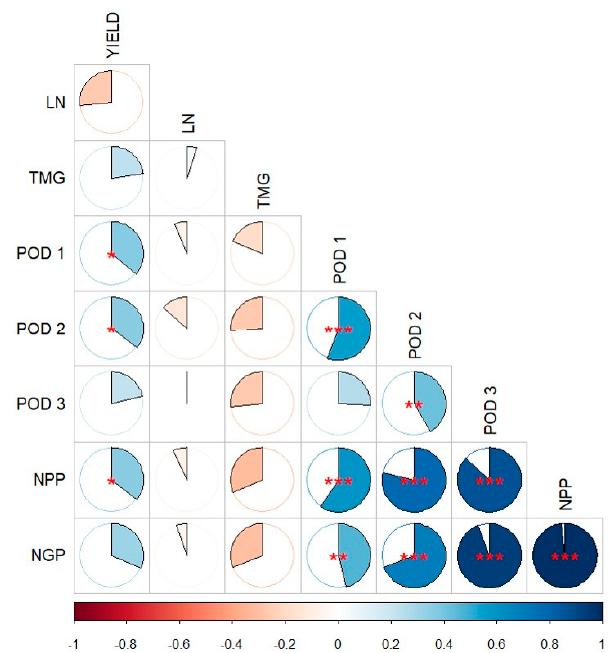
Figure 2. Pearson linear correlation matrix between soybean yield components for the year 2018–2019: pod one grain (POD 1), pod two grain (POD 2), pod three grain (POD 3), number pod per plant (NPP), number of grain per plant (NGP), leaf nitrogen (LN), thousand mass grains (TMG), and yield. Note: * significant at 10%, ** significant at 5%, *** significant at